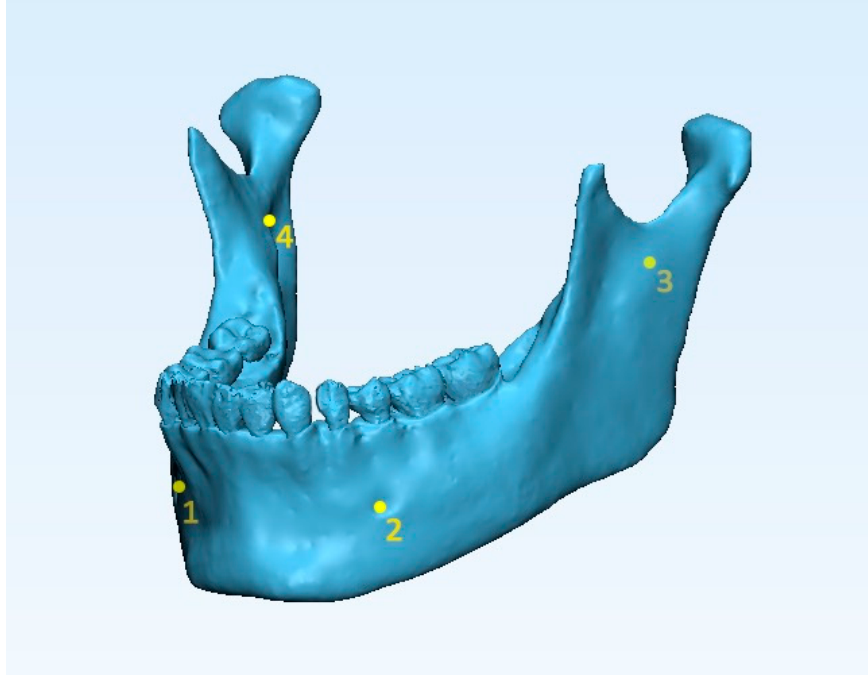
Figure 2. Landmarking four points on 3D mandibular model superimposition: 1–2, the geometric center of Table 3. left and right mandibular lingual at the inner surface of ramus.